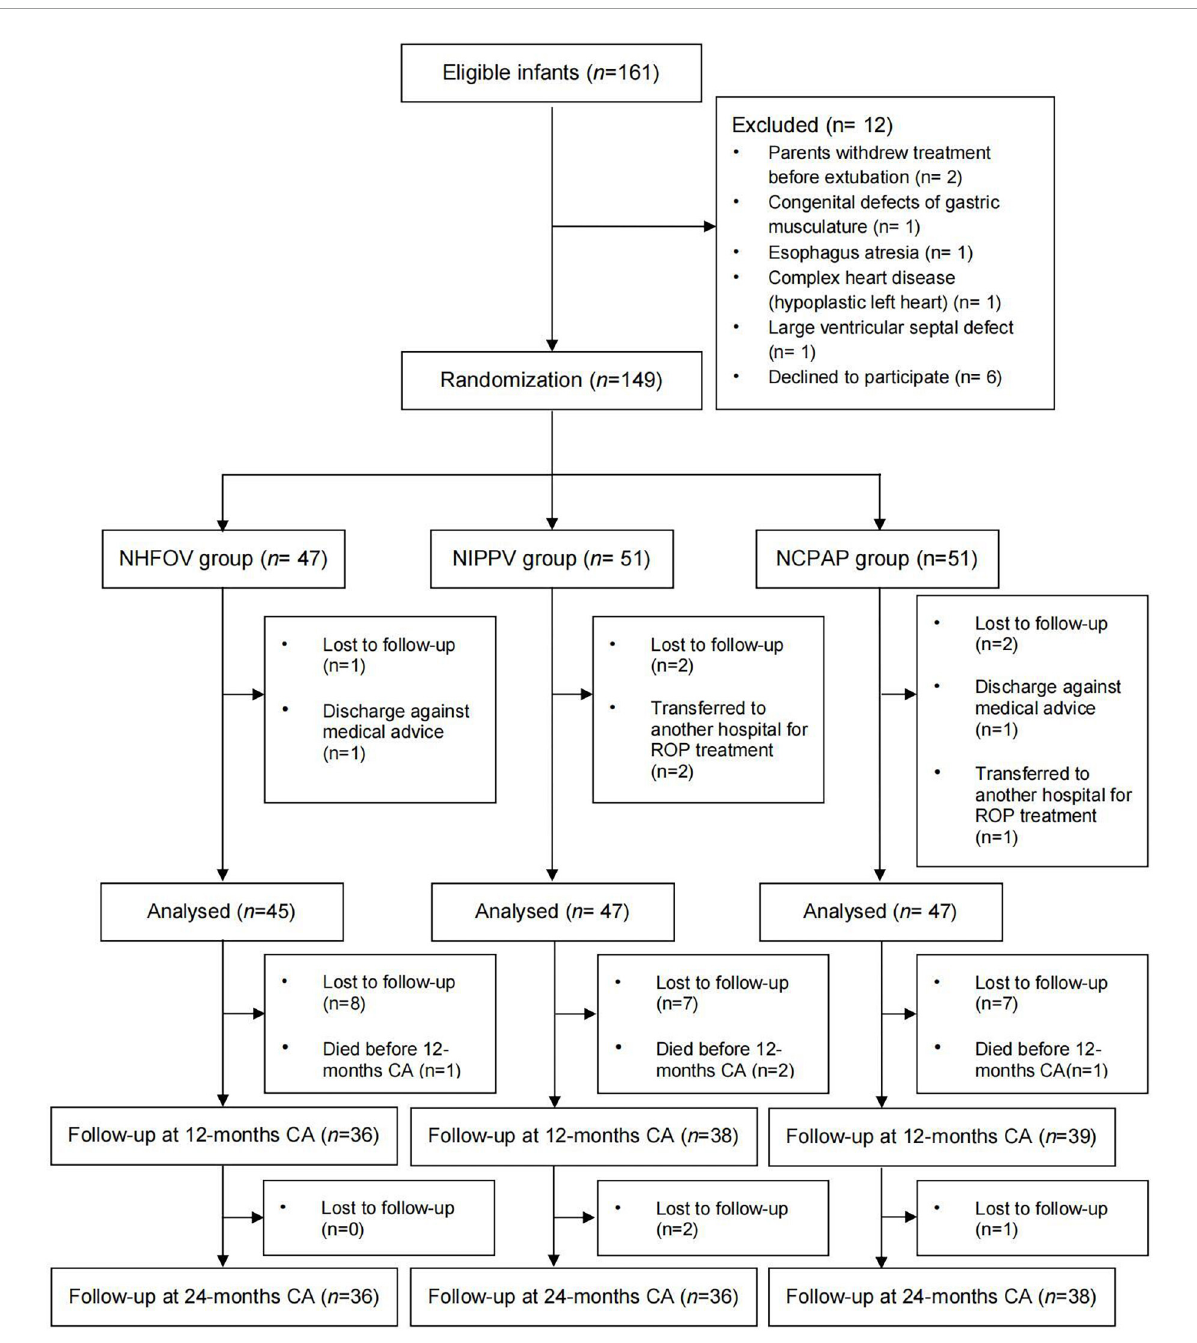
FIGURE1 Diagram showing the flow of participants through each stage of the study. NHFOV, non-invasive high-frequency oscillatory ventilation; NIPPV, nasal intermittent positive pressure ventilation; NCPAP, nasal continuous positive airway pressure; CA, corrected age.